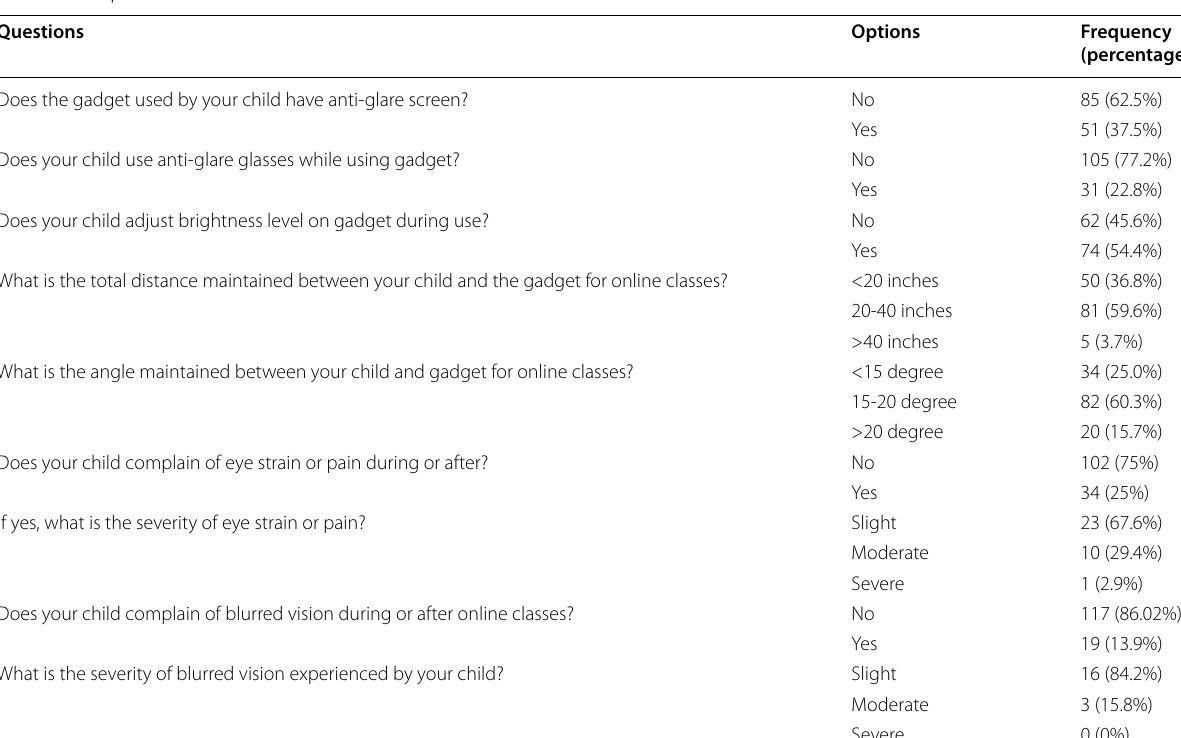
Table 4 Responses of the vision